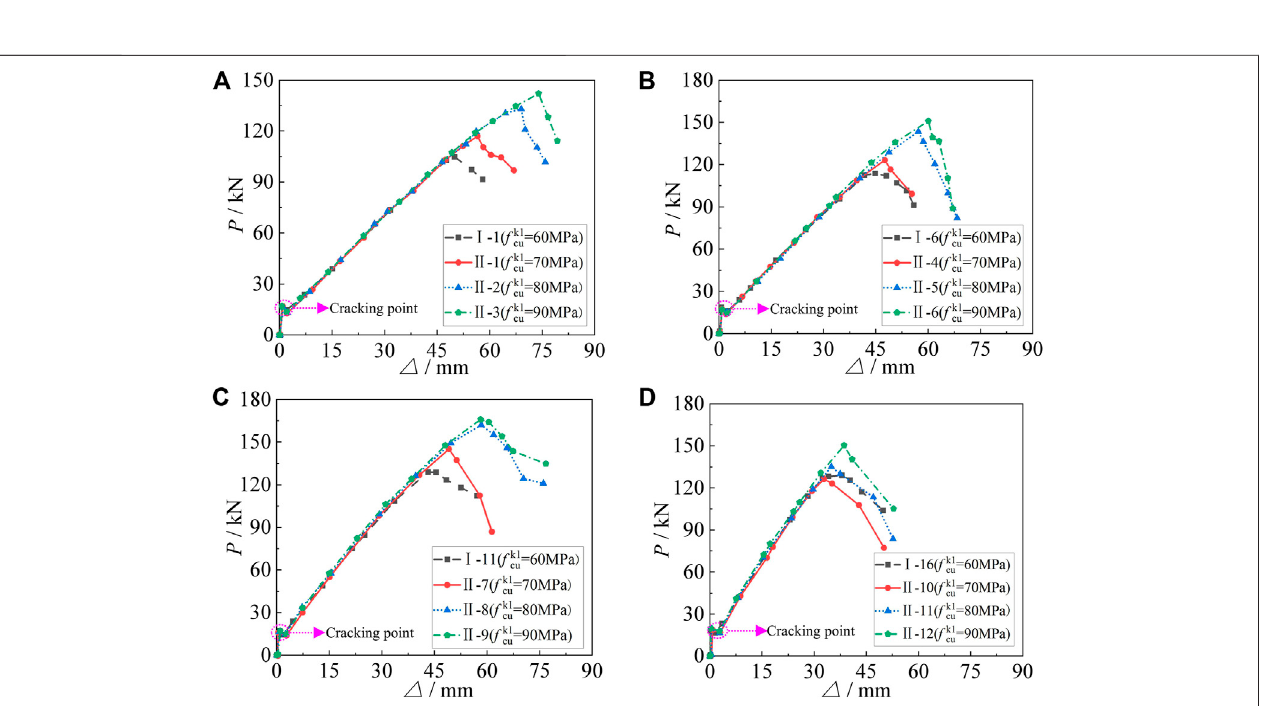
Frontiers in Materials |